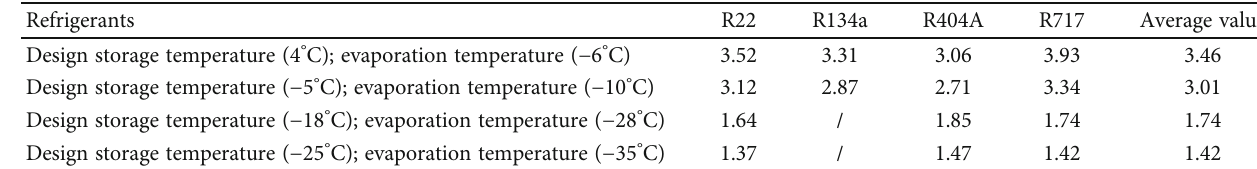
Table 4: COP calculations of four refrigerants at di ff erent storage temperatures.